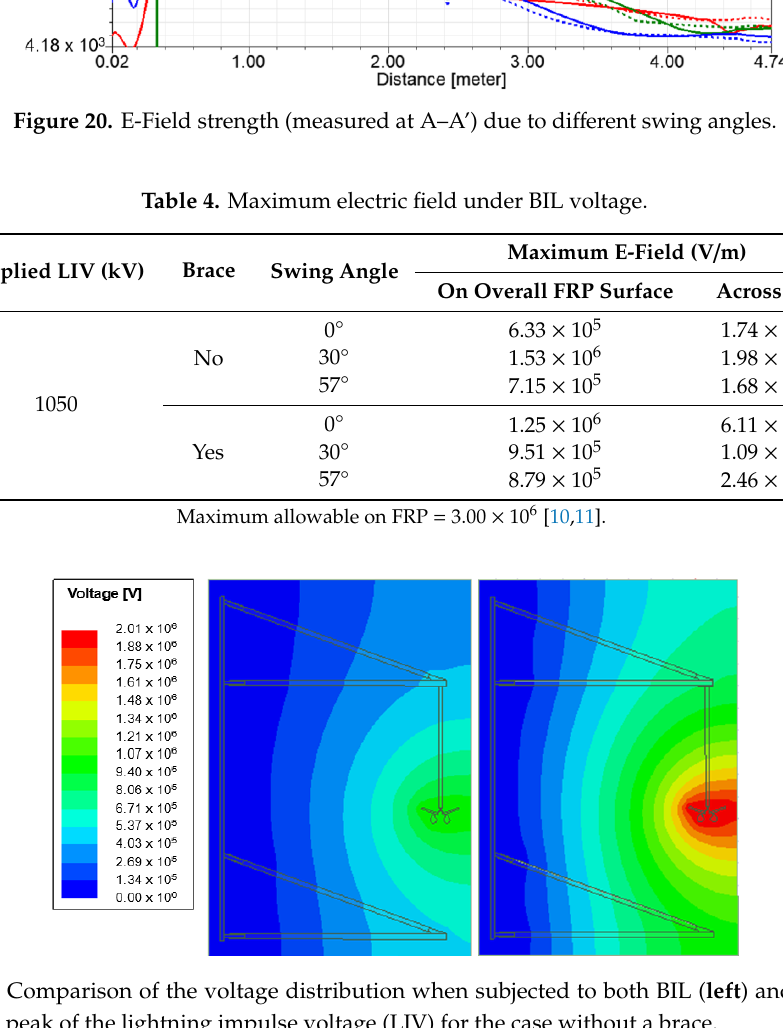
Figure 21. Comparison of the voltage distribution when subjected to both BIL ( left ) and SF ( right ) during the peak of the lightning impulse voltage (LIV) for the case without a brace. Table 5. Maximum electric field under SF voltage.